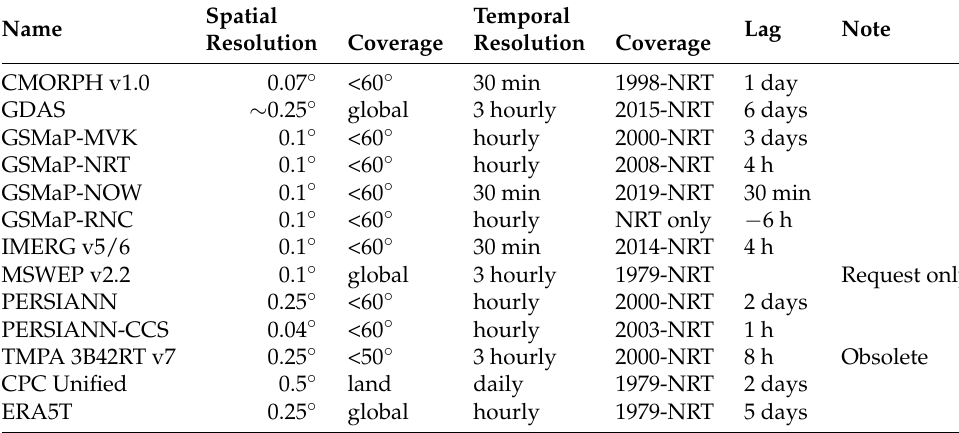
Table 2. Overview of precipitation data products. Adapted from Satgé et al. [62] and Beck et al. [63,64], showing only data sources with at least Near Real Time (NRT) coverage. A spatial resolution of 0.1 ◦ is approximately equal to 11 × 11 km at the equator, or 8 × 11 km at 45 ◦ N/S (e.g., Alps). Lag is the relative age of the latest available